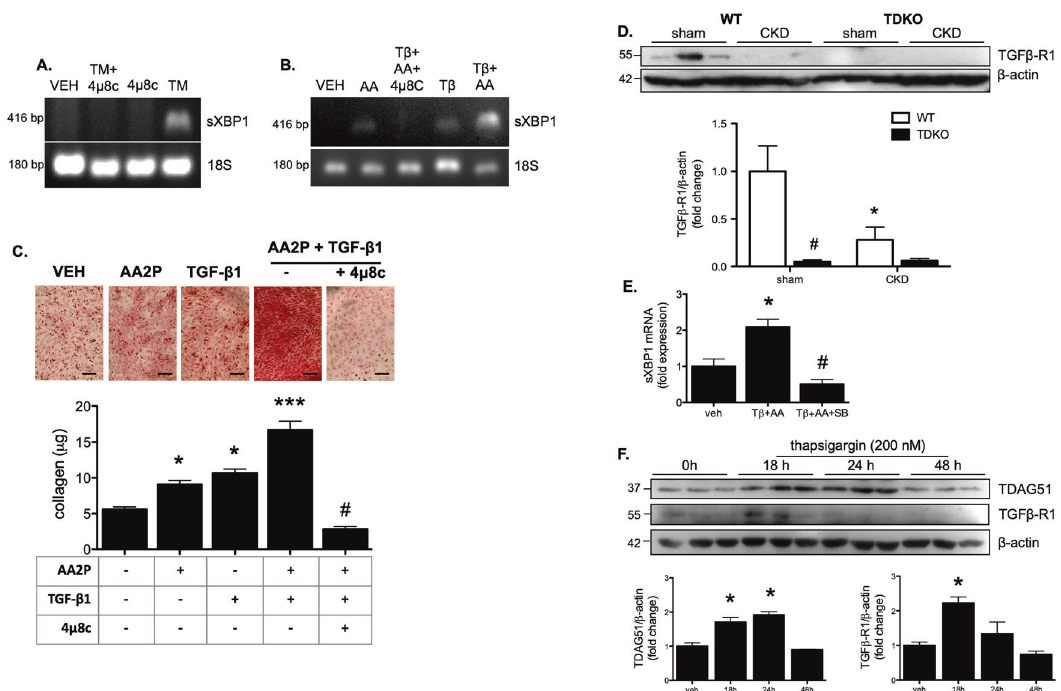
Fig. 6 Renal interstitial fi brosis is mediated by sXBP1. A Rat renal fi broblasts were treated with TM and the IRE1 endonuclease inhibitor 4 μ 8c. TM-induced splicing of XBP1, which was prevented by 4 μ 8c treatment. B Renal fi broblasts were treated with TGF- β 1 (T β ) and ascorbic